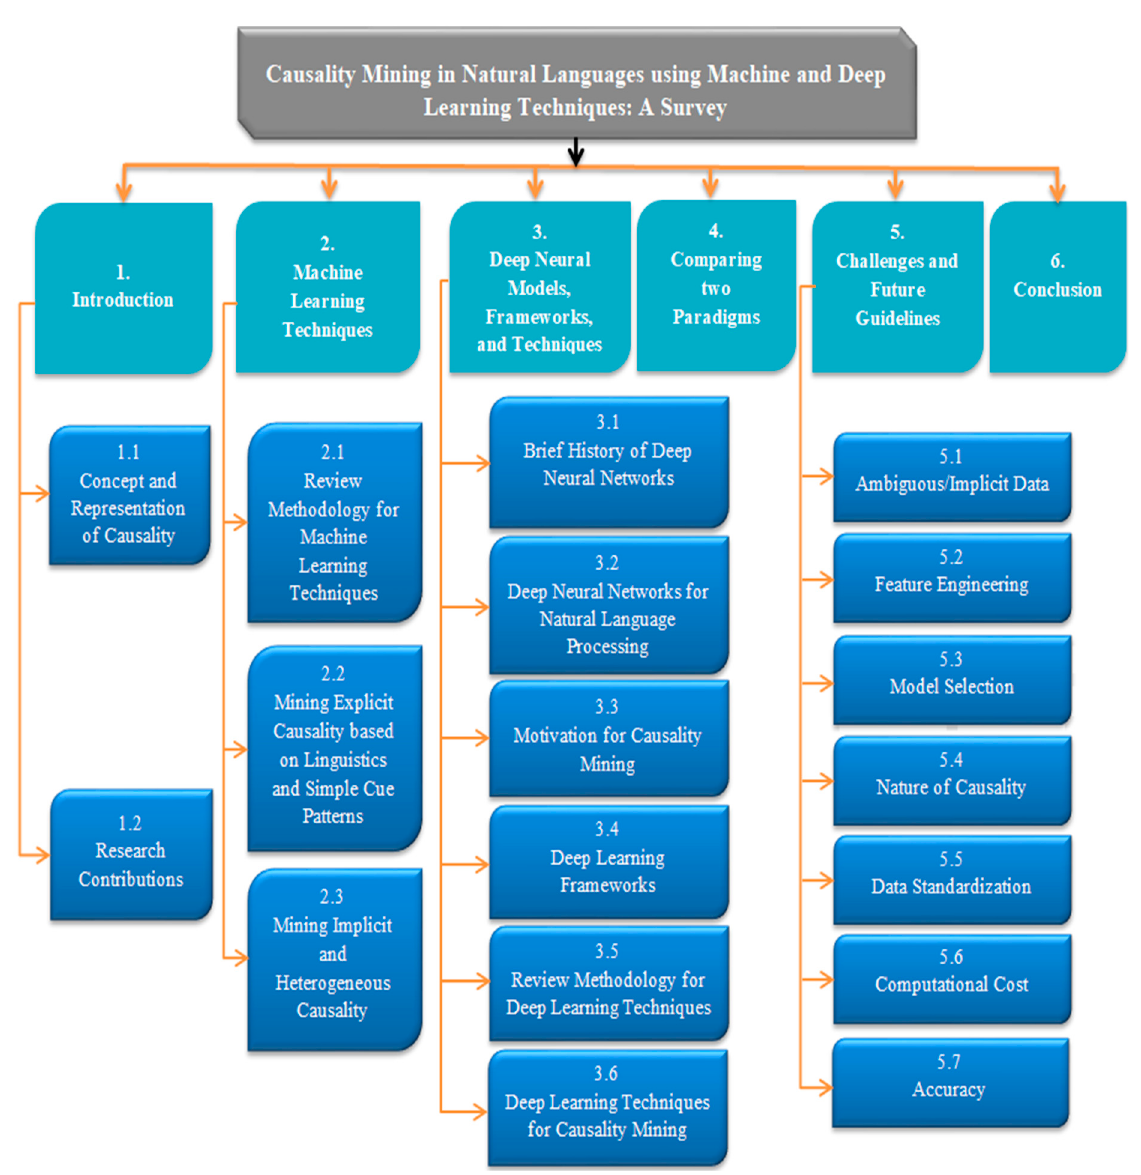
Figure 2. Taxonomy of most commonly used machine learning network for causality mining.